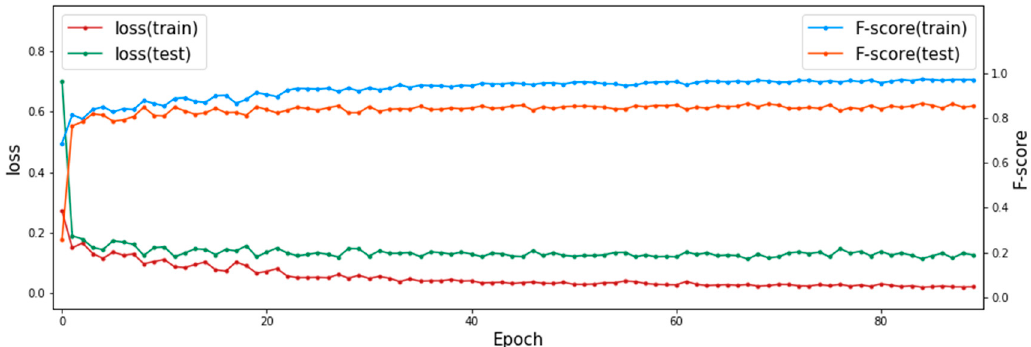
Figure 10. DICE loss and F-score predicted by MSMKU-MMLM at different training iterations.